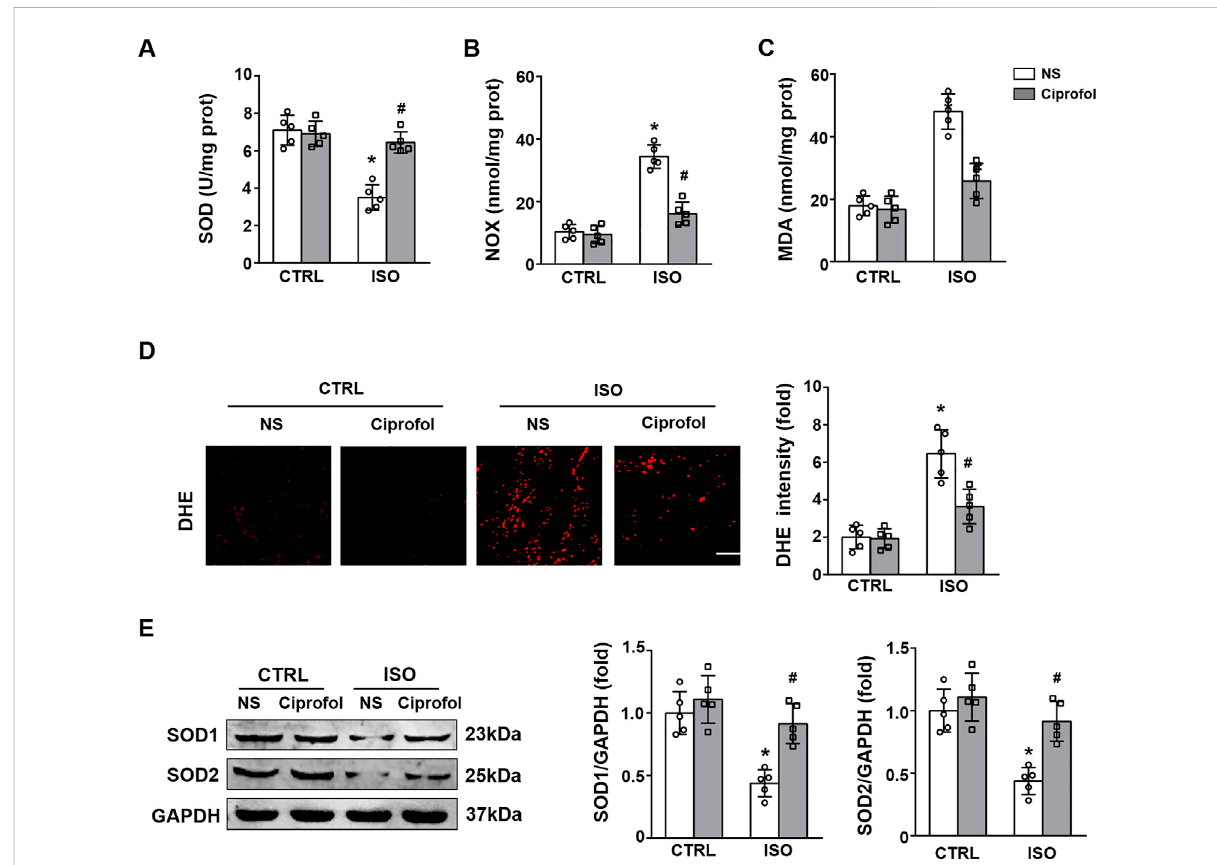
FIGURE 3 Ciprofol treatment attenuated ISO-induced oxidative stress. SOD (A) , NOX (B) and MDA (C) levels in each group were assessed ( n = 5). (D) DHE stainingandthequantitativeresults( n =5;scalebar,50 μ m) (E) WesternblottinganalysisofSOD1,andSOD2intheheart( n =5). p p < 0.05compared to the CTRL group. # p < 0.05 compared to the ISO